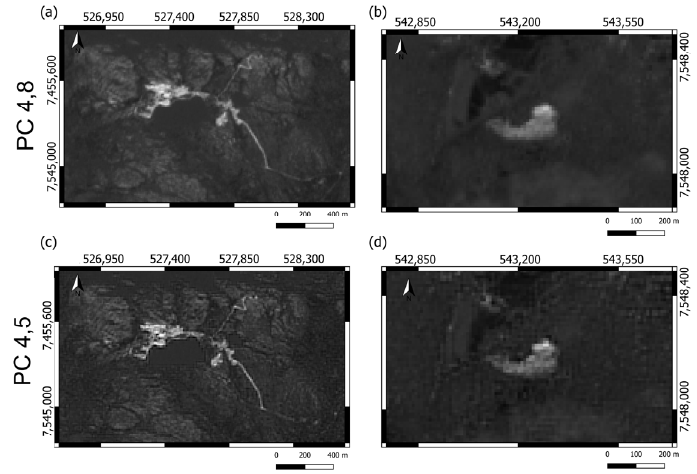
Figure 17. Comparison of PCA results of bands 4 and 5 and 4 and 8. ( a ) Håkonhals mine in focus for PCA 4, 8. ( b ) Jennyhaugen mine in focus for PCA 4 And 8. ( c ) Håkonhals mine in focus for PCA 4, 5. ( d ) Jennyhaugen mine in focus for PCA 4, 5.